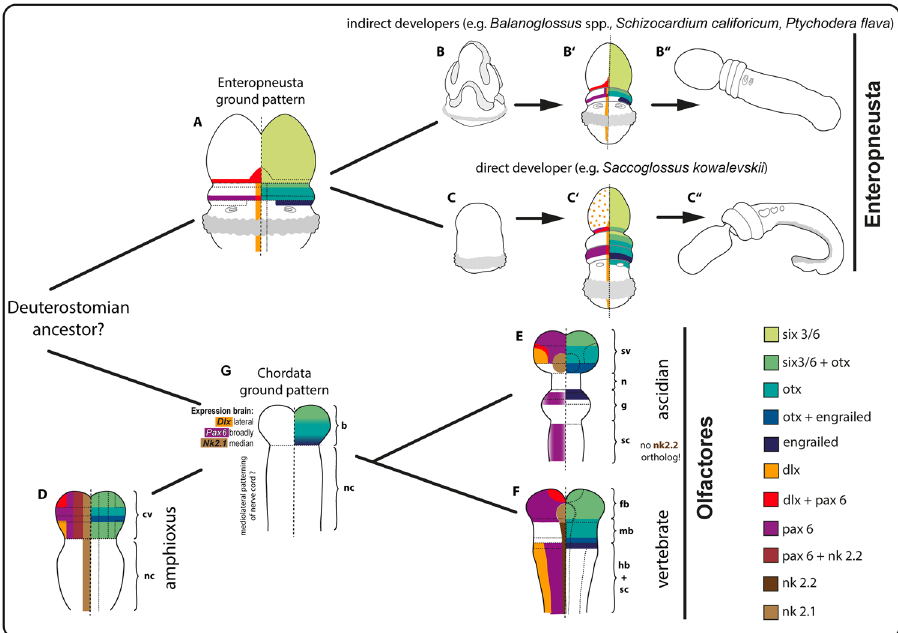
Figure 4. Comparison of axial patterning genes in the neural plate of diverse deuterostomian taxa with focus on different developing modes in enteropneusts. Neuronal patterning in enteropneusts is highly conserved and independent of the mode of development. The ancestral condition of mediolateral patterning for Deuterostomia remains elusive. See text for discussion. ( A ) Expression domains of the hypothetical enteropneust ancestor. ( B–B” ) Selected developmental stages of B. misakiensis . ( B ) Metschnikoff larval stage. ( B’ ) Metamorphosing Agassiz larval stage (this study). ( B” ) Juvenile worm. ( C–C” ) Selected developmental stages of S. kowalevskii . ( C ) Torpedo embryo stage. ( C’ ) 1-gill slit hatchling (after data from refs 15, 16). ( C” ) Juvenile worm. ( D ) Expression domains in the neural plate of Branchiostoma floridae (after data from refs 34–36, 38, 39, 55). ( E ) Expression domains in the neural plate of the ascidian Ciona intestinalis (after data from refs 34, 40, 56–58). F Expression domains in the neural plate of the vertebrate Mus musculus . Scheme modified after 2 (after data from refs 3, 16, 31, 37). ( G ) Expression domains of the hypothetical chordate ancestor. Mediolateral patterning of the postcerebral nerve cord is ambiguous. Note, all expression patterns are symmetrical, but are shown on one side only for clarity. b = brain, cv = cerebral vesicle, fb = forebrain, g = ganglion, hb = hindbrain, mb = midbrain, n = neck, nc = nerve cord, sc = spinal cord, sv = sensory